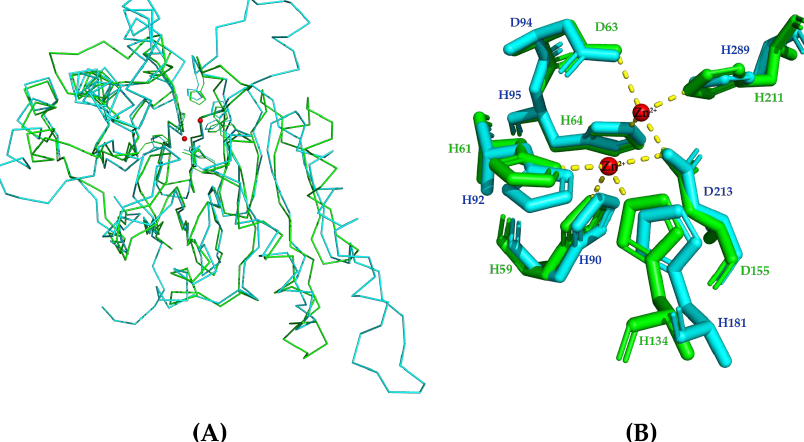
Figure 6. Structural alignment of PaAst and YhfI (PDB: 6KNT, chain A). ( A ) Ribbon representation of PaAst and YhfI. PaAst is in blue, YhfI is in green, and Zn 2+ is in red, and the side chains of metal ion binding sites are shown by lines. ( B ) Comparison of the metal ion binding sites. The metal ion binding site of PaAst is in blue, YhfI is in green, and Zn 2+ is in red. Although several MBL-fold arylsulfatases have been reported in recent decades, lim- ited knowledge could be obtained from their structures. In this study, our sequence and functional analyses revealed that PaAst is an arylsulfatase, and the specific activity, K m and V max of purified recombinant PaAst, was observed by 39.45 U/mg, 1.00 mM, and 60.80 U/mg at 50 °C, respectively. Its structure was determined at 2.0 Å and formed a dimer with MBL fold, which could be the first MBL-fold arylsulfatase reported with its structure determined. The identification and characterization of AtsA-like arylsulfatases had indi- cated the existence of MBL-fold arylsulfatases for years, and the structure of PaAst